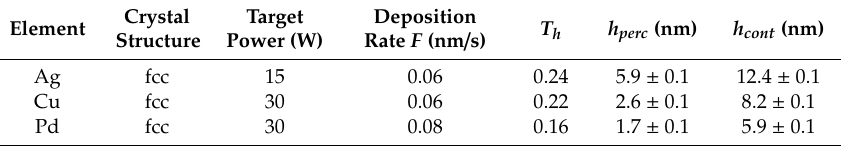
Table 1. Deposition conditions and characteristic morphological transition thicknesses for Ag, Cu and Pd films deposited by magnetron sputtering at T = 300 K on SiO 2 . The Ar working pressure is 0.3 Pa.